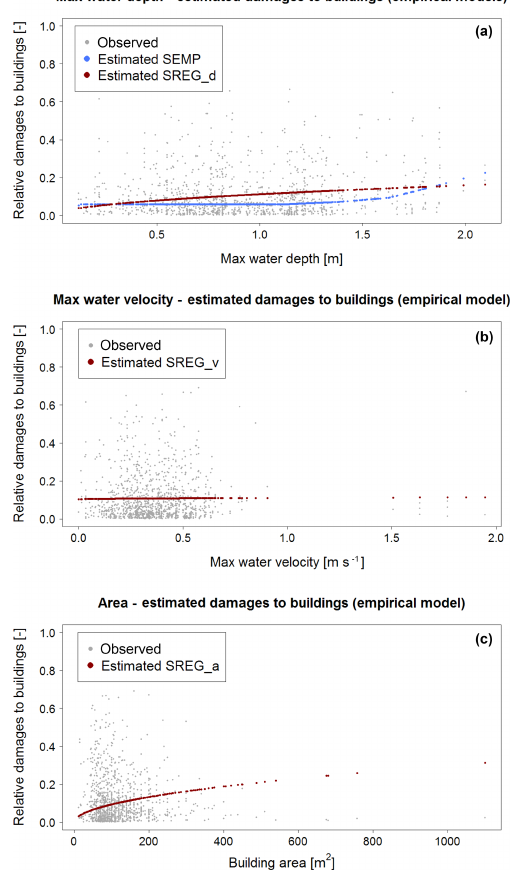
Figure 7. Relative damages to buildings estimated with (a) SEMP (blue dots) and SREG d (dark red dots), (b) SREG v (dark red dots), and (c) SREG a (dark red dots). Grey points in the background rep- resent observed relative loss to